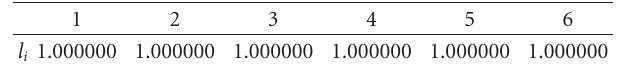
Table 3: The length of the strut C i A i (m).